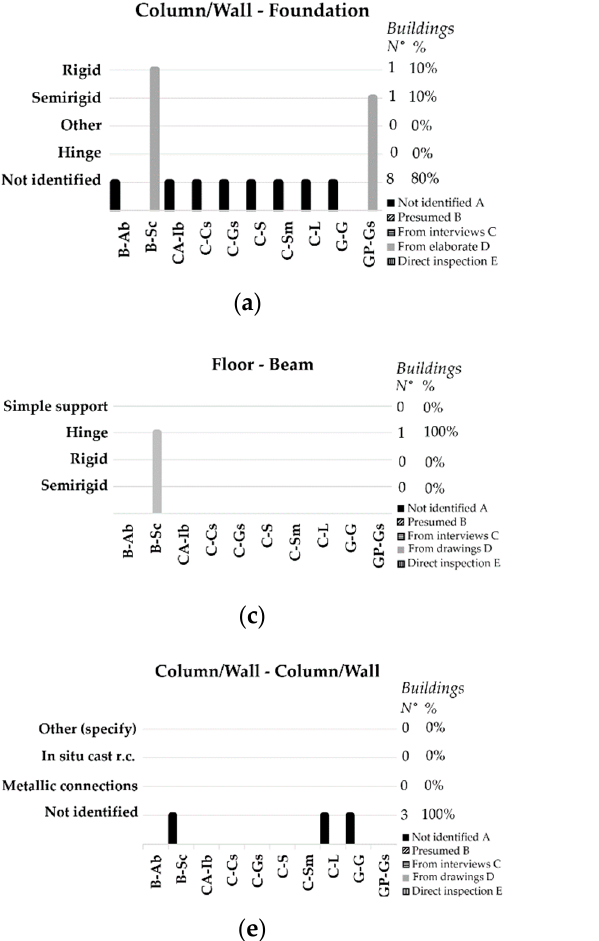
Figure 23. Section 3D CARTIS-Districts. Characterization of timber type: ( a ) Type and ( b ) Distribution of bracing systems. Figure 23b shows the distribution of the bracing systems in the longitudinal and transverse directions for each of the six buildings. In particular, in the transverse direction, five out of six buildings (83%) have braces on 100% of the length and one out of six